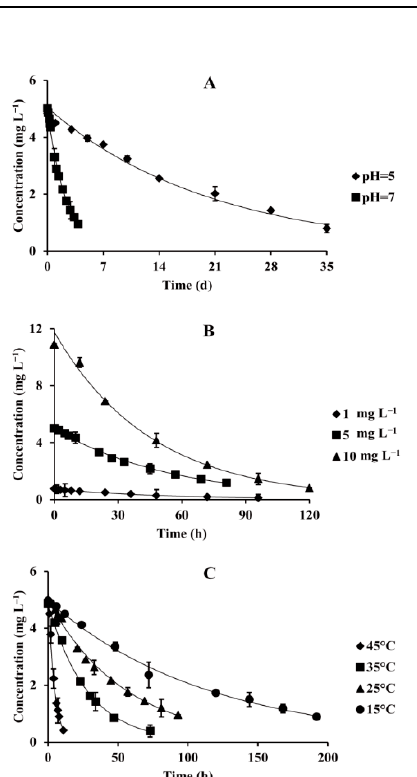
Figure 2. Effect of different pH values (( A ), spiked at 5 mg L −1 , 25 °C), initial concentrations (( B ), 25 °C, pH = 7), and temperatures (( C ), spiked at 5 mg L −1 , pH = 7) on the hydrolysis of FBEZF in water. A plot of ln k against 1/T provided a linear line in the temperature range 288–318 K and yielded the Arrhenius expression ln k = −6103.4 (1/T) + 16.464. The Ea and ΔH were calculated as 49.90 and 47.38 kJ mol −1 , respectively. Ea and ΔH determined the occurrence rate of pesticide hydrolysis. The large activation energy means it has a large energy difference between ground and transition states.